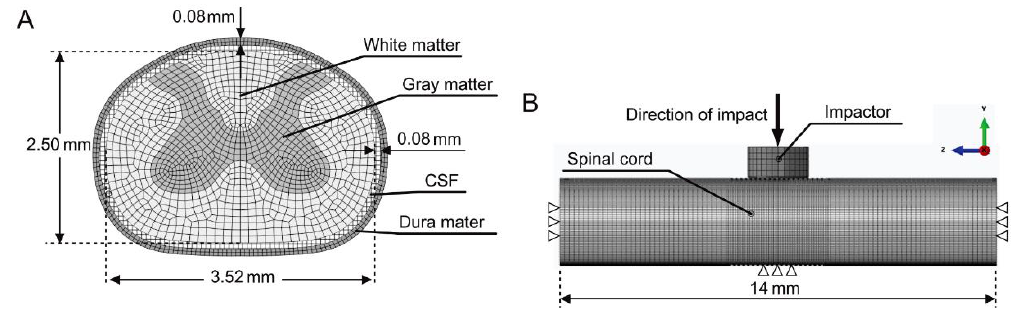
Figure 1. ( A ) Axial view of the cervical spinal cord in the rat finite element (FE) model. ( B ) Sagittal view of the spinal cord model with an impactor.